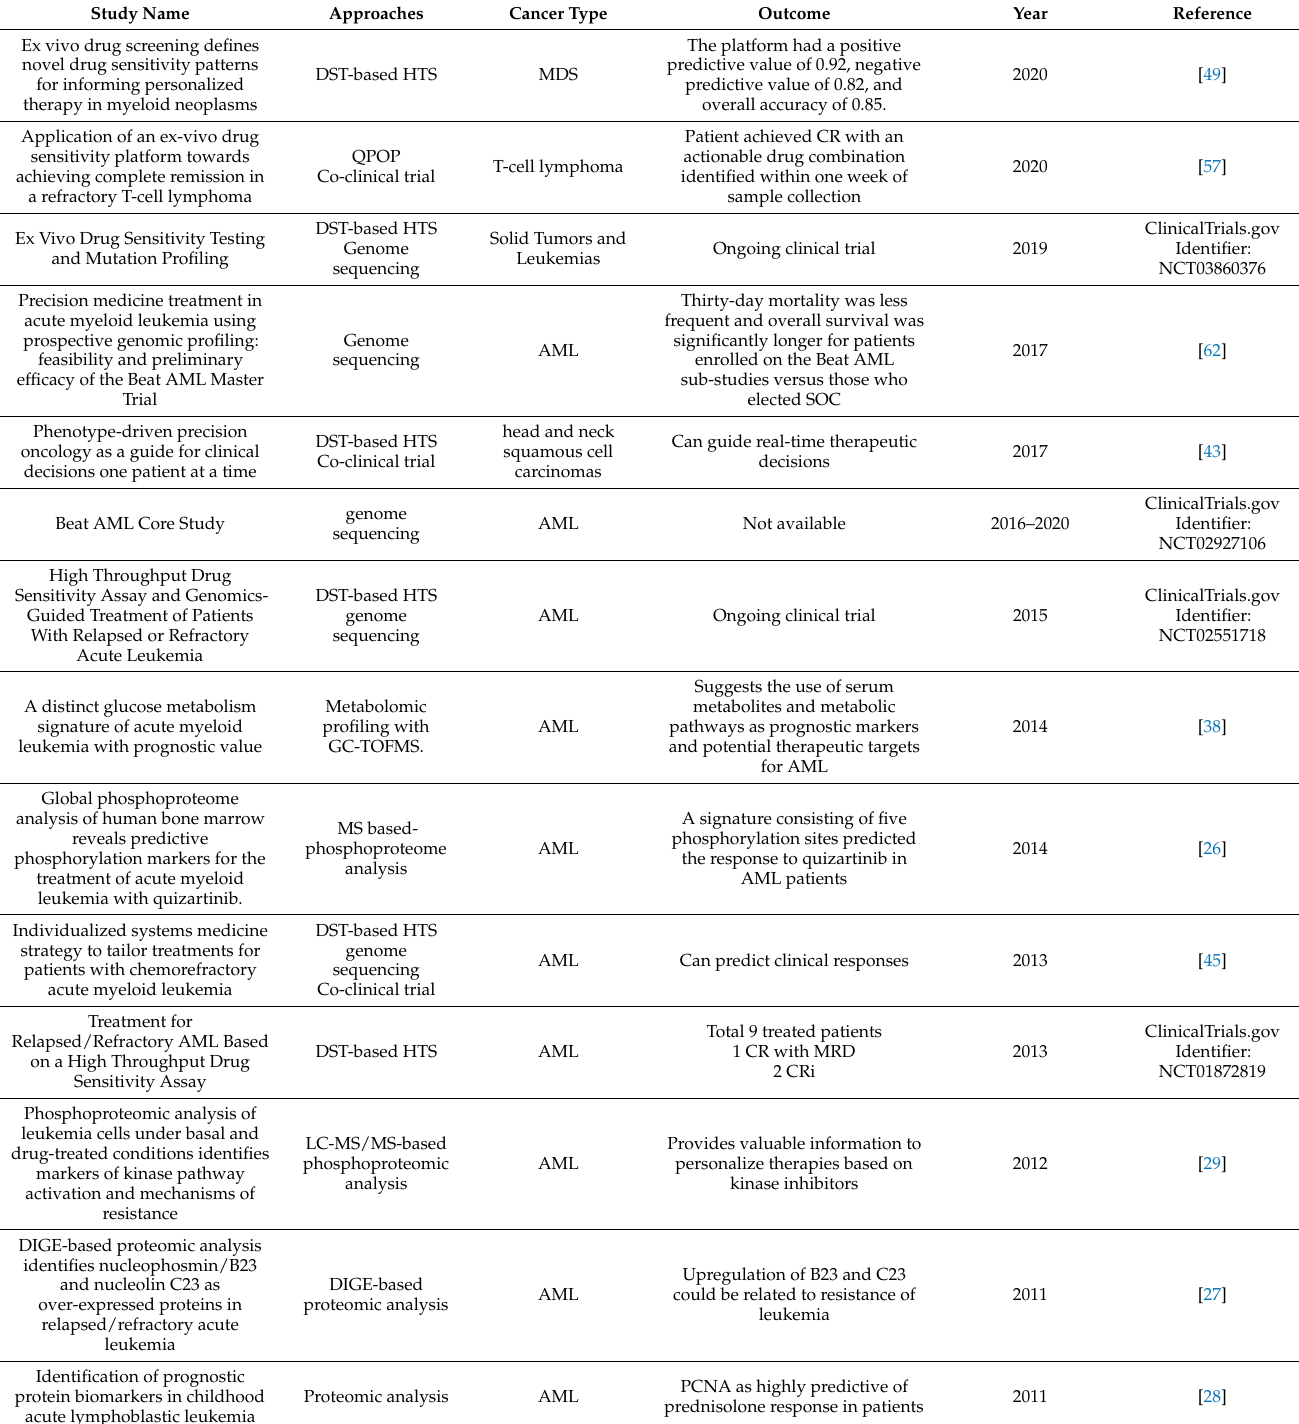
Table 1. Pre-clinical and clinical studies integrating high throughput technologies in the development of personalized treatment in AML and other